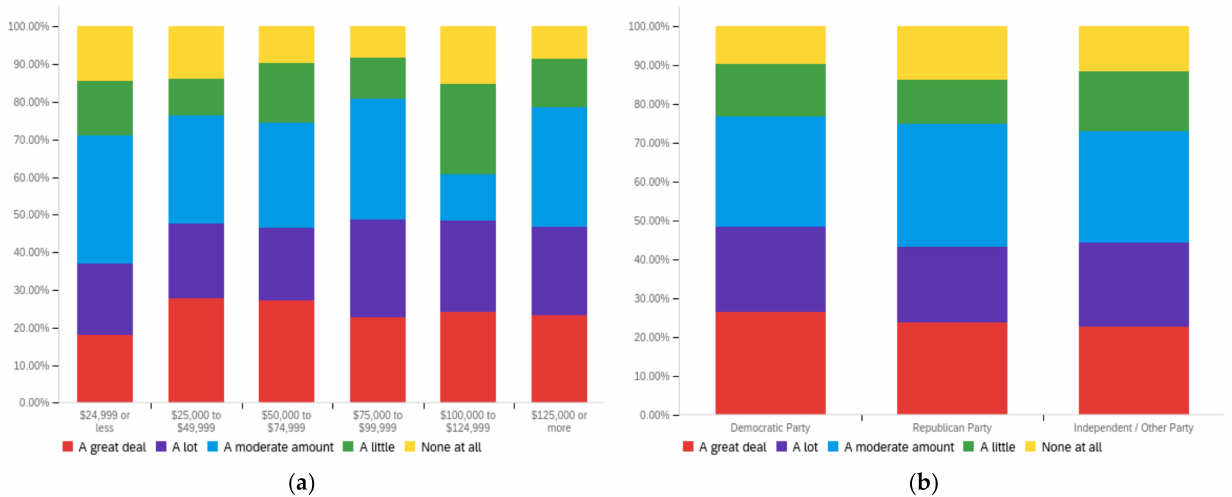
Figure A22. Cont